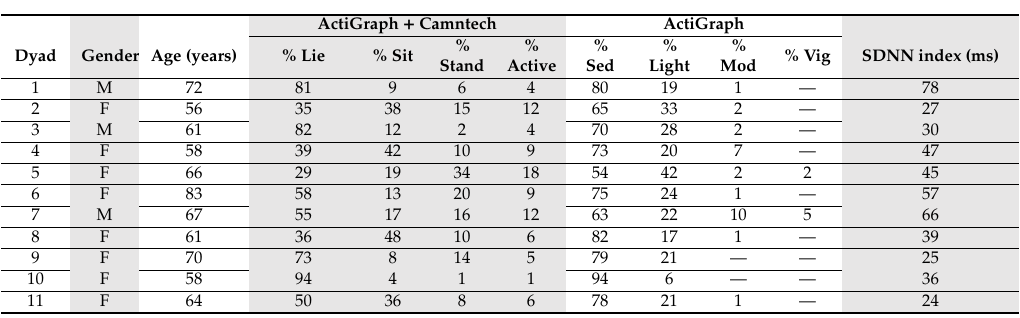
Table 4. Human caregivers: position, activity, and HRV over 24-hour period.